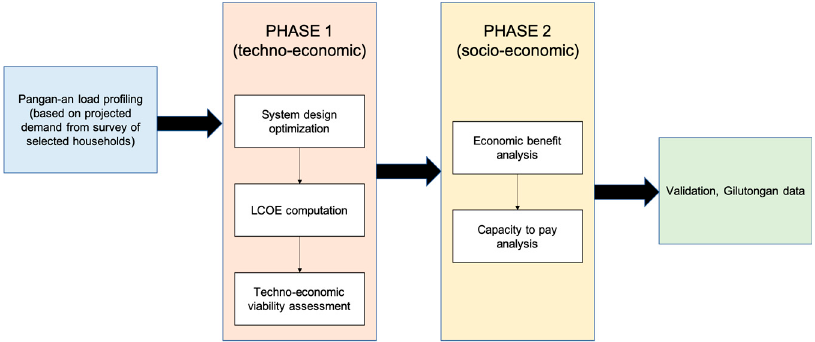
Figure 2. Research